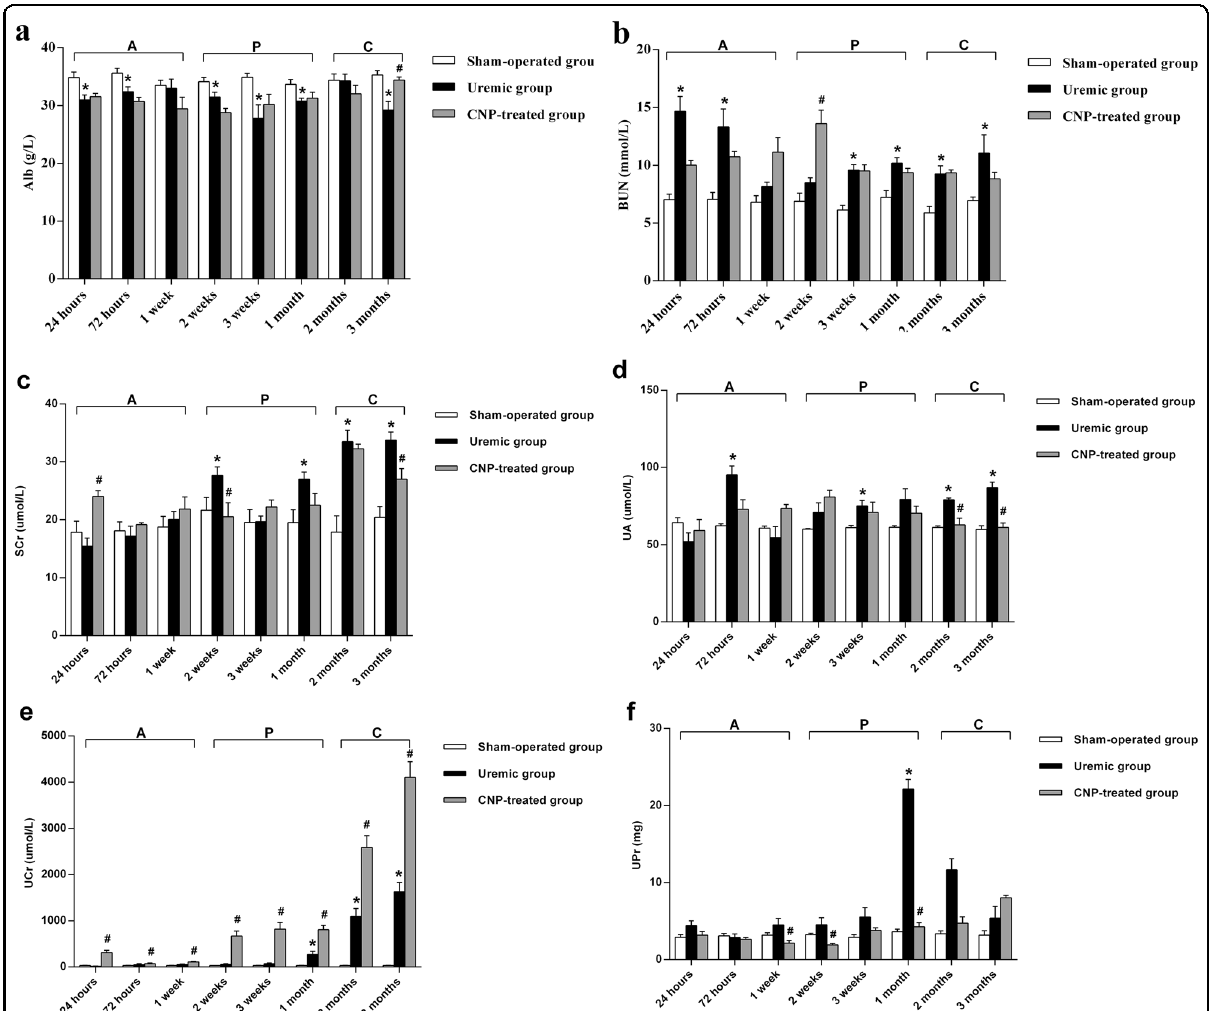
Fig. 1 Renal function indices in sham-operated, uremic and CNP-treated rats. Uremic group vs. sham-operated group : Serum Alb in the uremic group was signi fi cantly decreased throughout the observational period ( a ); serum BUN and UA in the uremic group were signi fi cantly higher in every stage ( b , d ); SCr, UCr, and UPr were elevated in the progressive stage and chronic stage ( c , e , and f ). CNP-treated group vs. uremic group : hypoalbuminemia in the uremic group could be dramatically reversed by CNP until 3 months ( a ); SCr, UA, and BUN in the CNP-treated group were markedly higher at 24 h, 1 and 2 weeks posttreatment, respectively, whereas SCr was signi fi cantly decreased in both the progressive stage and chronic stage, and UA was signi fi cantly decreased only in the chronic stage ( b – d ); The CNP-treated group showed a dramatic elevation in UCr at each time point ( e ); CNP administration resulted in a prominent reduction in UPr from the acute stage to the progressive stage ( f ). CNP-treated group vs. sham-operated group : the levels of Alb, SCr, UA, and UPr in the CNP-treated group gradually became similar to those in the sham-operated group at 3 months postoperatively ( a , b , d , and f ). * P < 0.05, signi fi cantly different from the corresponding sham-operated group; # P < 0.05, signi fi cantly different from the corresponding uremic group. A acute stage, P progressive stage, and C chronic